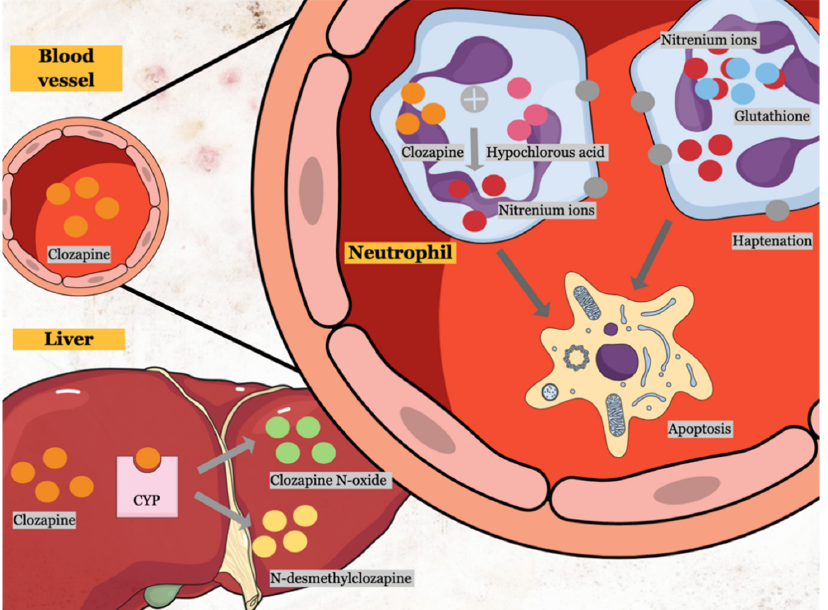
Figure 2. Mechanism of clozapine-induced neutrophil toxicity. Clozapine is metabolized by cyto-